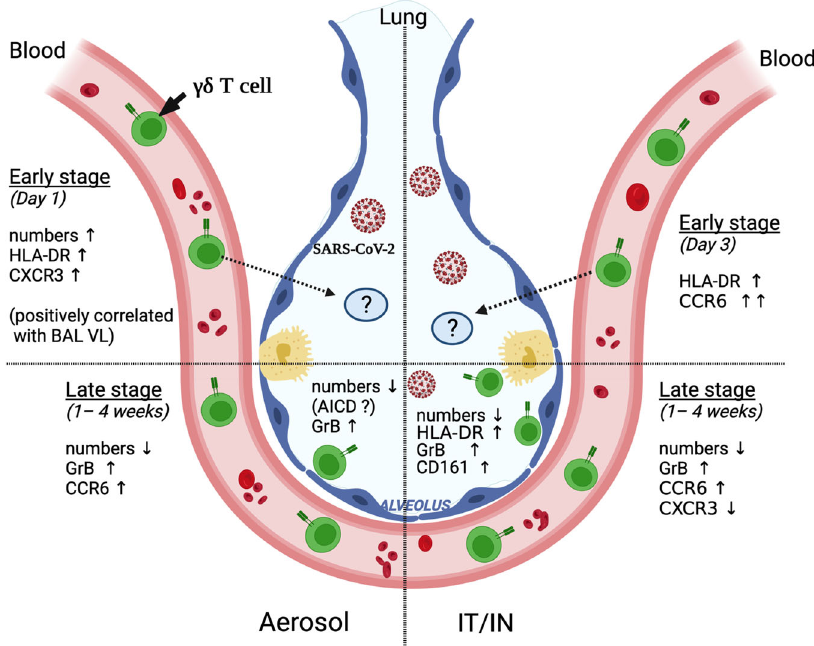
Fig. 9 Peripheral blood and lung γδ T cell responses during SARS-CoV-2 infection. Rapid activation (HLA-DR + ) and expansion of circulating γδ T cells with increased CXCR3 expression, as observed following aerosol exposure in NHPs, may enable their migration to sites of virus replication in the airways. Later stages are marked by a signi fi cant decline in blood γδ T cells and consistently increased GrB and CCR6 expression in both routes of exposure, supporting killing of infected cells and repair of alveolar epithelia in the recovery phase. In the lungs, greater frequencies of activated (HLA-DR + ), cytotoxic (GrB + ) and CD161 + γδ T cells during the recovery phase may be involved in viral clearance and repair of alveolar epithelium. The differences in γδ T cell mobilization and effector functions may underlie the diverse clinical spectrum of COVID-19. Schematic created with BioRender.com